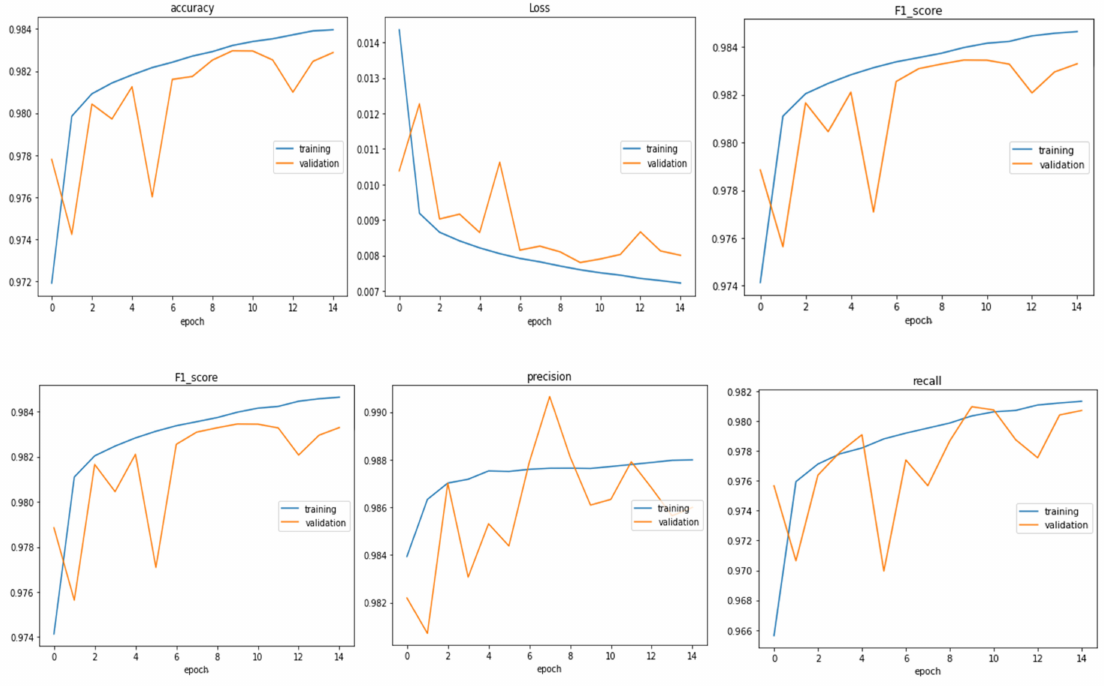
Figure 19. The training and validation accuracy, F1-score, loss, recall, and precision after training the Inception Time model with a window size of six using the UNSW-NB15